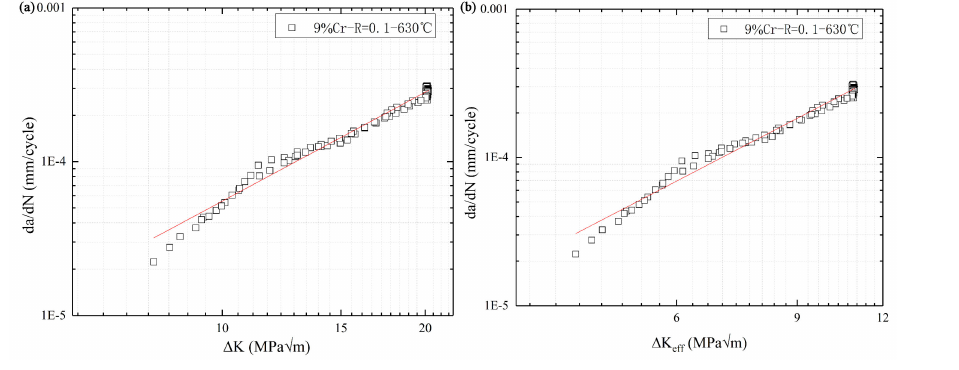
Figure 15. The curves of crack growth rate with R = 0.1 of 9%Cr; ( a ): K max − K min and ( b ): K max − K op .